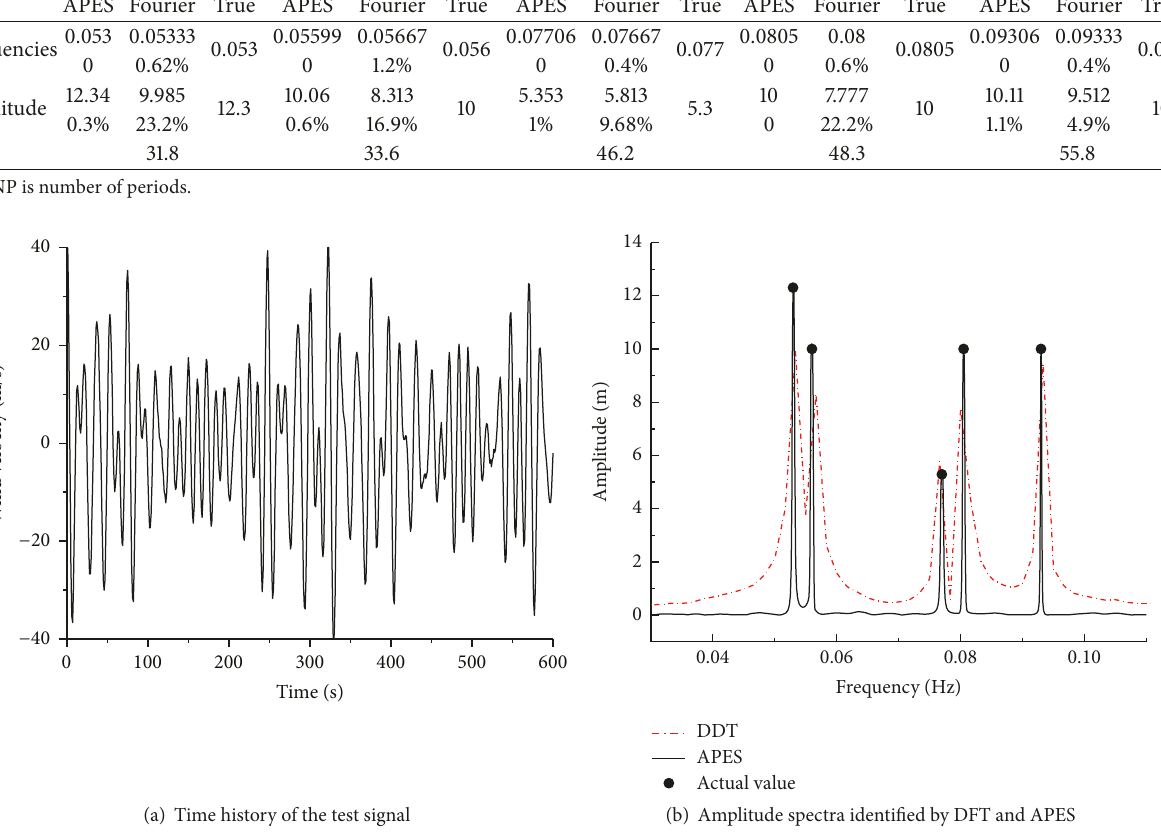
Figure 1: Test signal and the identified